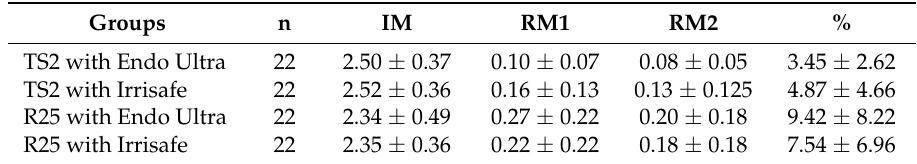
Table 1. The mean volume and standard deviation (mm 3 ) of the initial material (IM), residual material after the retreatment procedure (RM1), residual material after the additional cleaning method (RM2), and the mean percentage of the residual filling material (%) after applying the additional cleaning methods, according to the groups studied.